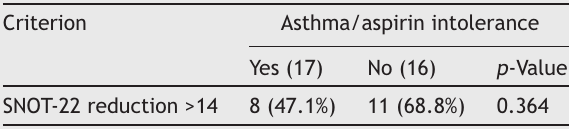
Subgroup analysis with/without asthma or aspirin